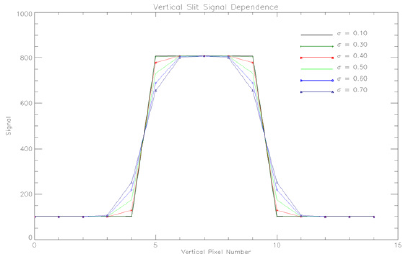
Figure 2. Signal in slit direction for a short slit. The influence of the 2D problem is in the middle of the slit negligible